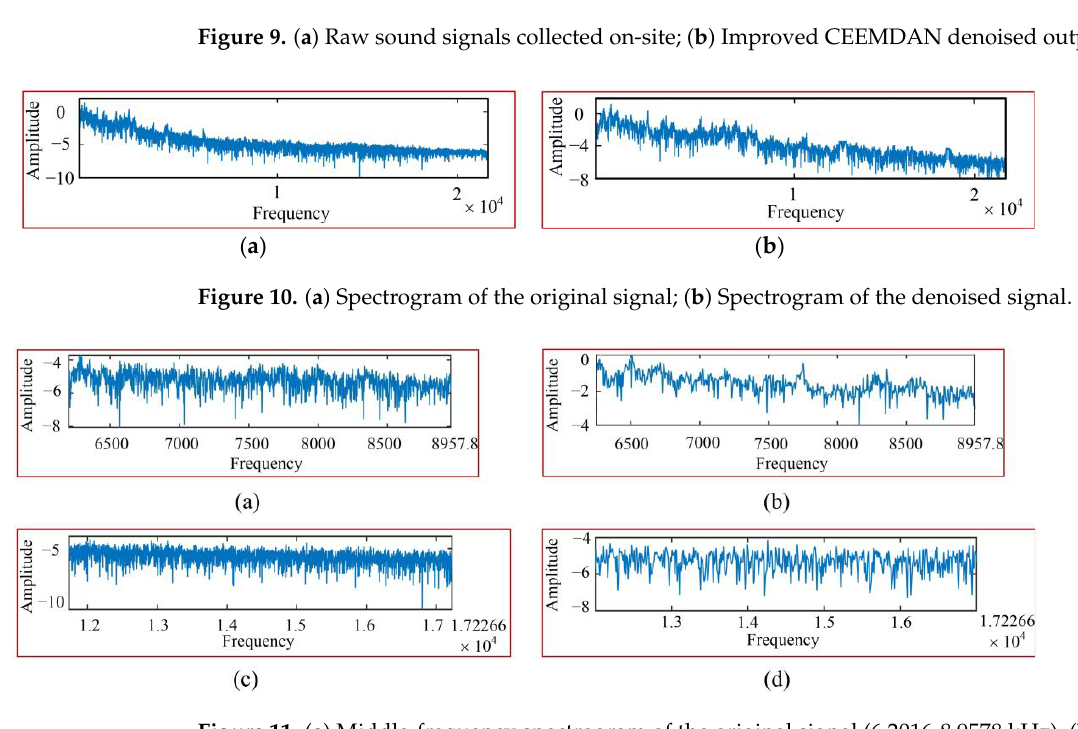
Figure 11. ( a ) Middle-frequency spectrogram of the original signal (6.2016-8.9578 kHz); ( b ) Middle- frequency spectrum of the denoised signal (6.2016-8.9578 kHz); ( c ) High-frequency spectrogram of the original signal (11.7141-17.2266 kHz); ( d ) High-frequency spectrum of the denoised signal (11.7141-17.2266